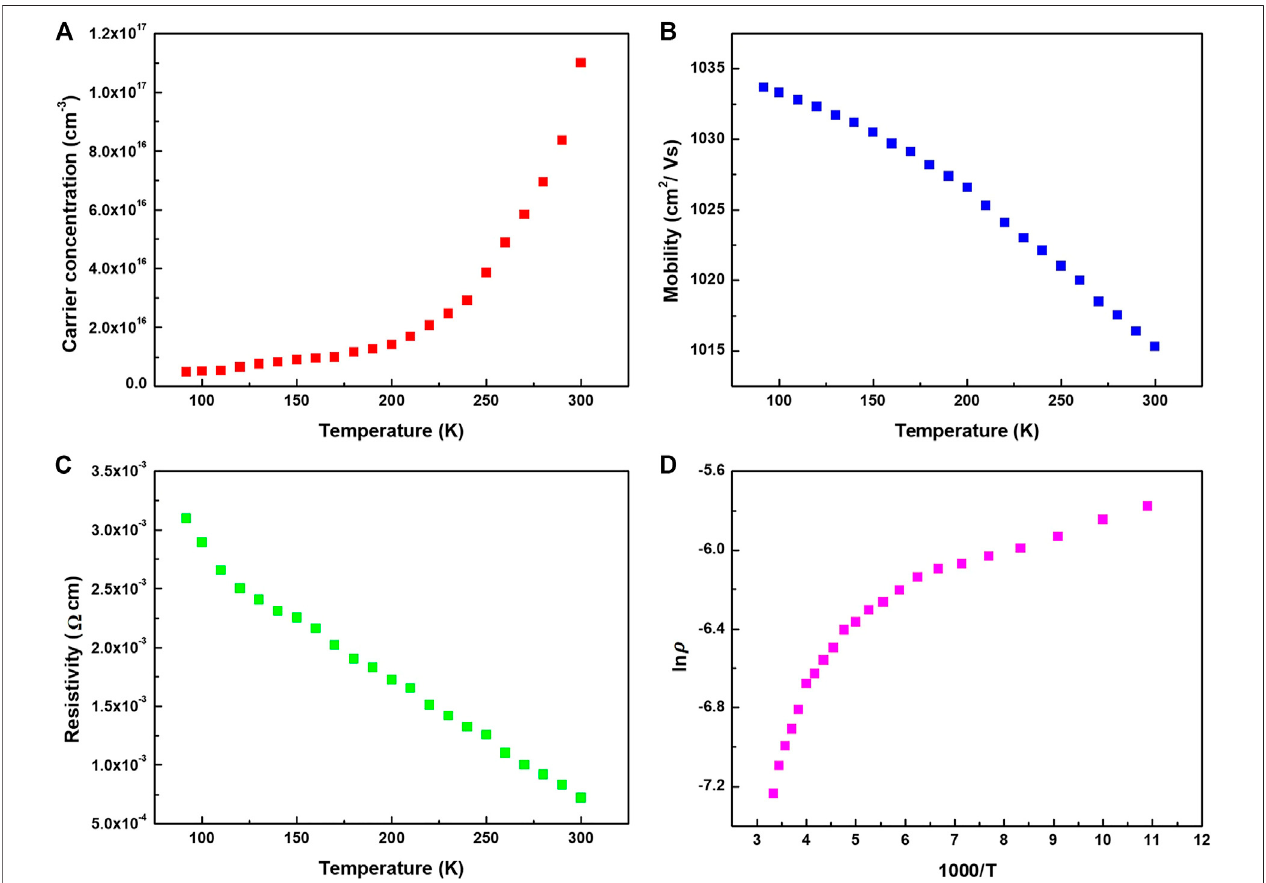
FIGURE5|(A) Temperaturedependenceof: (A) Carrier concentration, (B) Hallmobility, (C) electricalresistivity (D) ln ρ plottedasfunctionof1,000/TfortheBi 2 Se 3 thin fi lm.